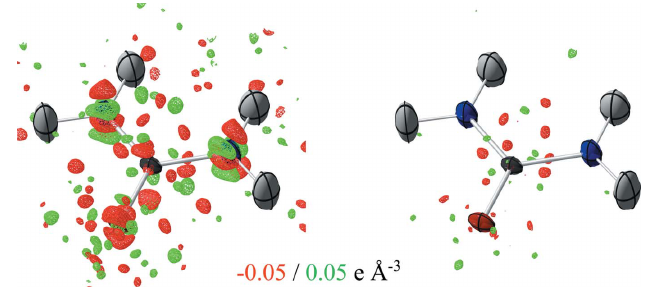
Figure 9 Difference electron-density plots for different refinements of urea. (Left) Refinement with SCAN PAW-HAR without Gram–Charlier expansion. (Right) Refinement with SCAN PAW-HAR with third (N, O) and fourth (N, O) degree Gram–Charlier